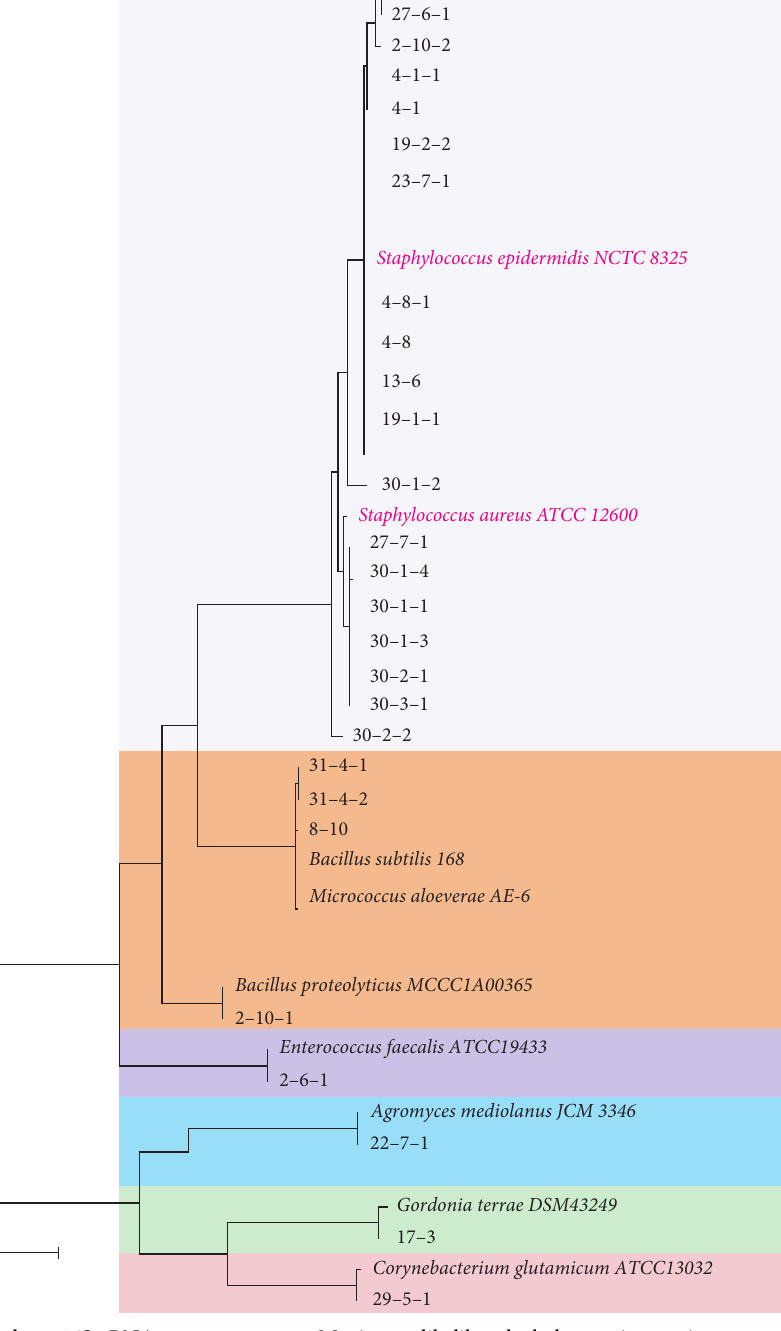
Figure 1: Phylogenetic tree based on 16S rRNA gene sequences. Maximum-likelihood phylogenetic tree is constructed based on the bacterial 16S rRNA gene sequences. Numbers at the nodes are ML bootstrap proportions. Bar represents 0.05 substitutions per nucleotide